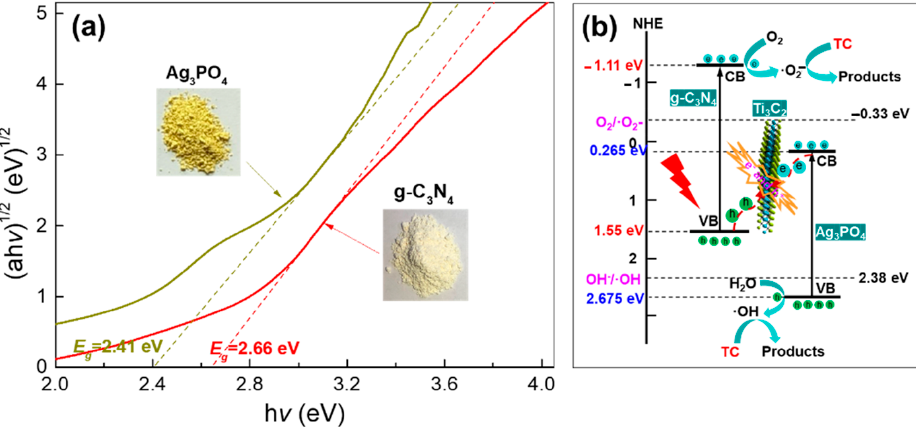
Figure 10. ( a ) The band gap width of g-C 3 N 4 and Ag 3 PO 4 , ( b ) The mechanism of catalytic oxidation degradation of TC by composite nano fi bers.